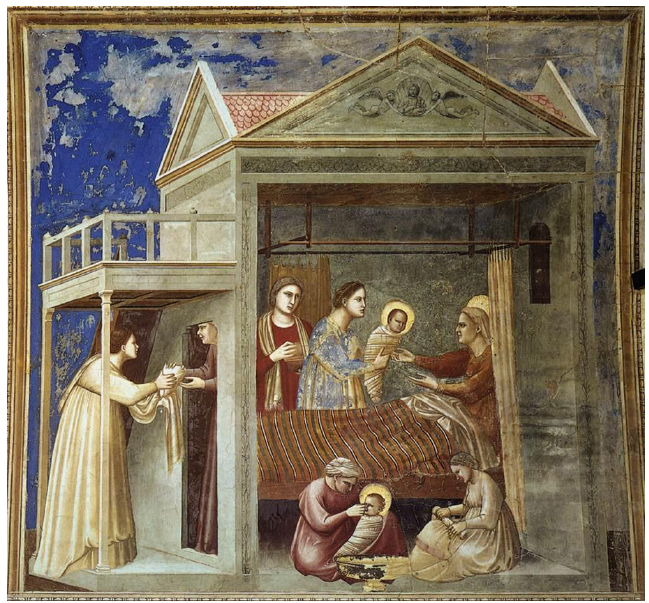
Fig. 2 Giotto da Bondone, Natività di Maria , 1303-1305 (Padova, Cappella degli